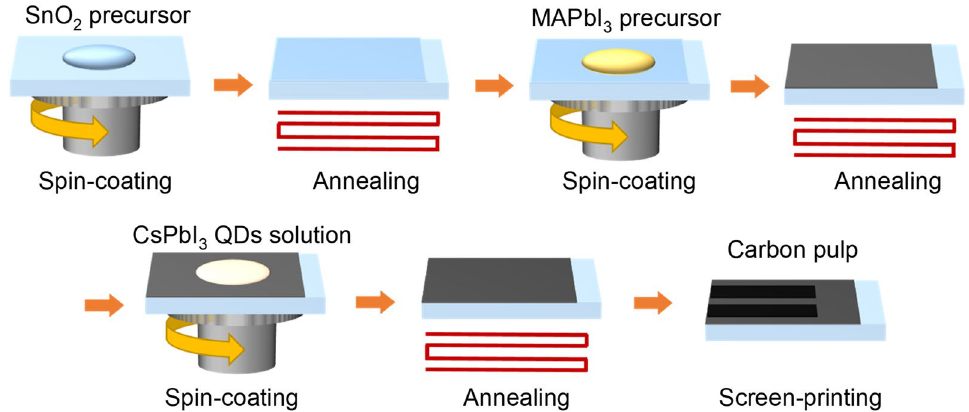
Fig. 1 Schematic diagram of the PD fabrication